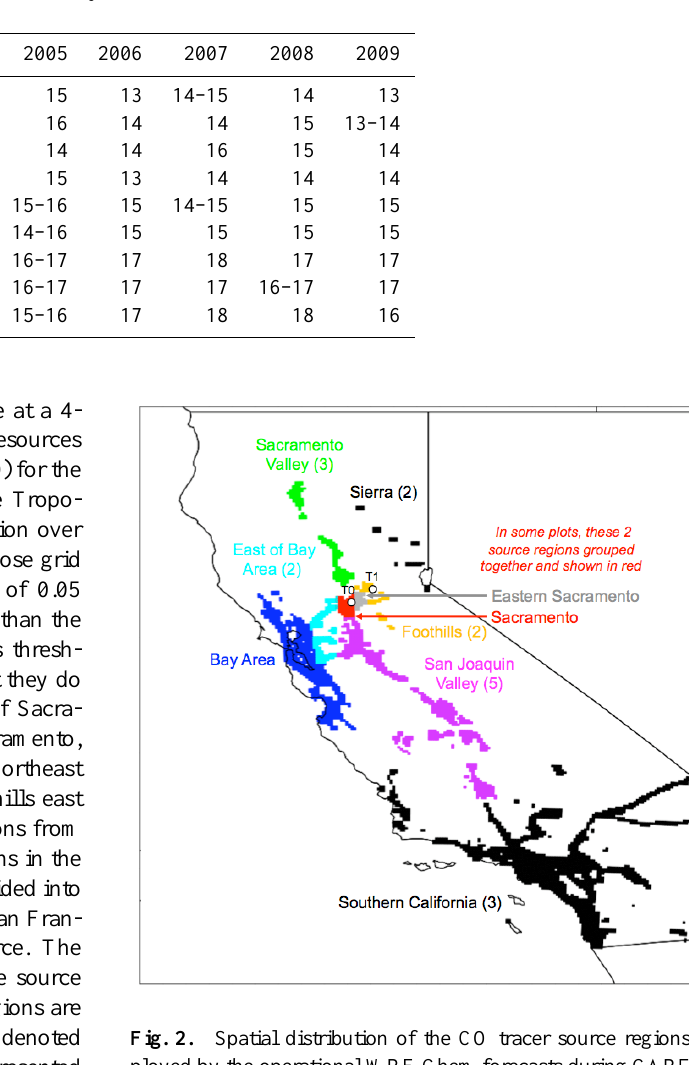
Table 2. Time of day (LST) in which peak ozone mixing ratio occurs most frequently during the month of June for stations shown in Fig. 1. Multiple hours are listed when the frequency of occurrence differs by one or zero.